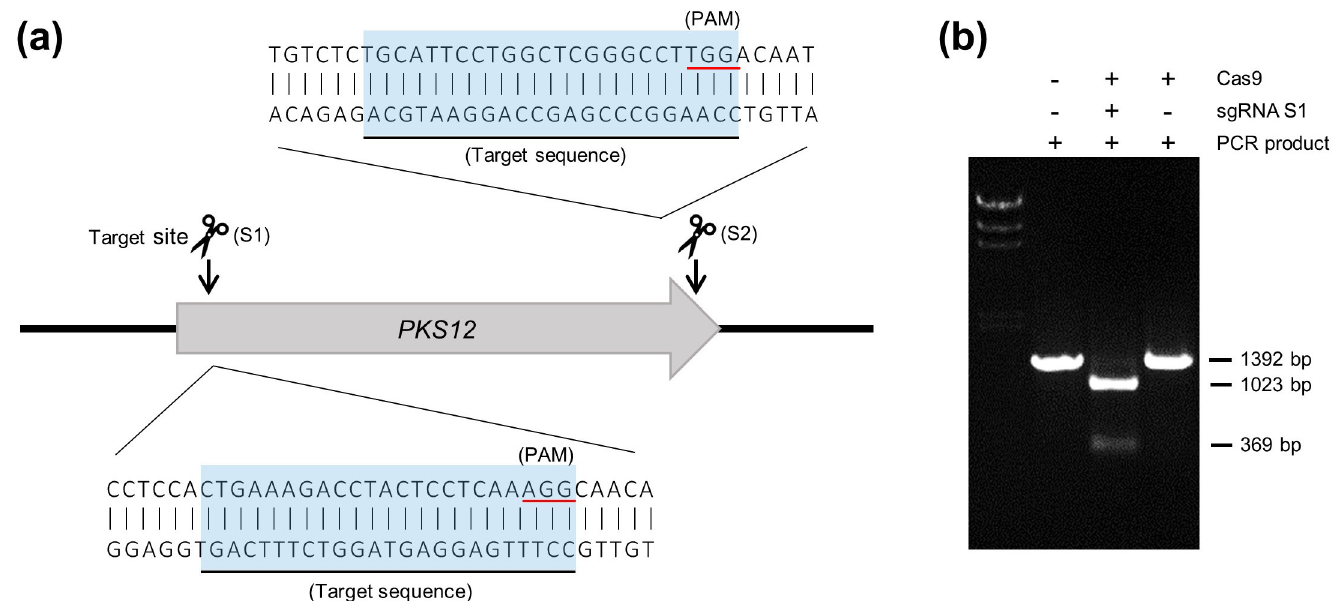
Fig 2. Schematic representation of the in vitro cleavage assay of preassembled Cas9 RNP. (a) Schematic representation of sgRNA design for in vitro cleavage assay and preassembled Cas9 RNP-mediated transformation. The two sgRNAs were designed to cleave two sites, S1 (49–71 bp) and S2 (6433–6455 bp), respectively. The protospacer adjacent motif sequence is required for Cas9 to recognize the target site. (b) In vitro cleavage assay. The results showed the activity of preassembled Cas9 RNP.